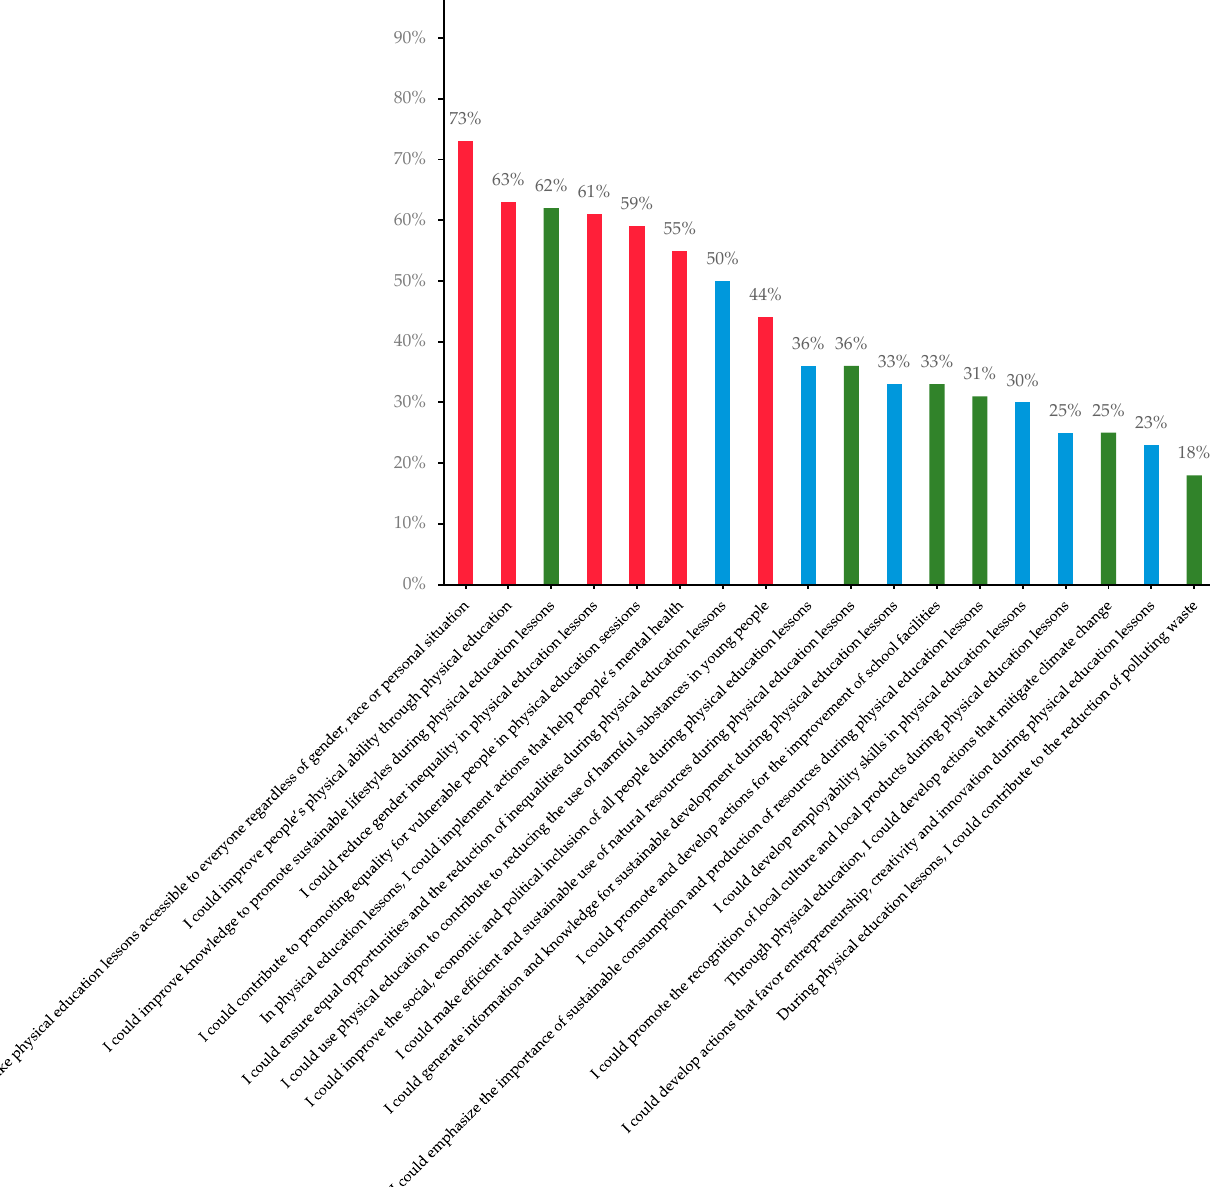
Figure 1. The proportions of participants (n = 1153) who agreed to each of the 18 items. Note: the items are in descending order from left to right. The colors represent different dimensions of SD: social dimension (red), the economic dimension (blue), and environmental dimension (green).